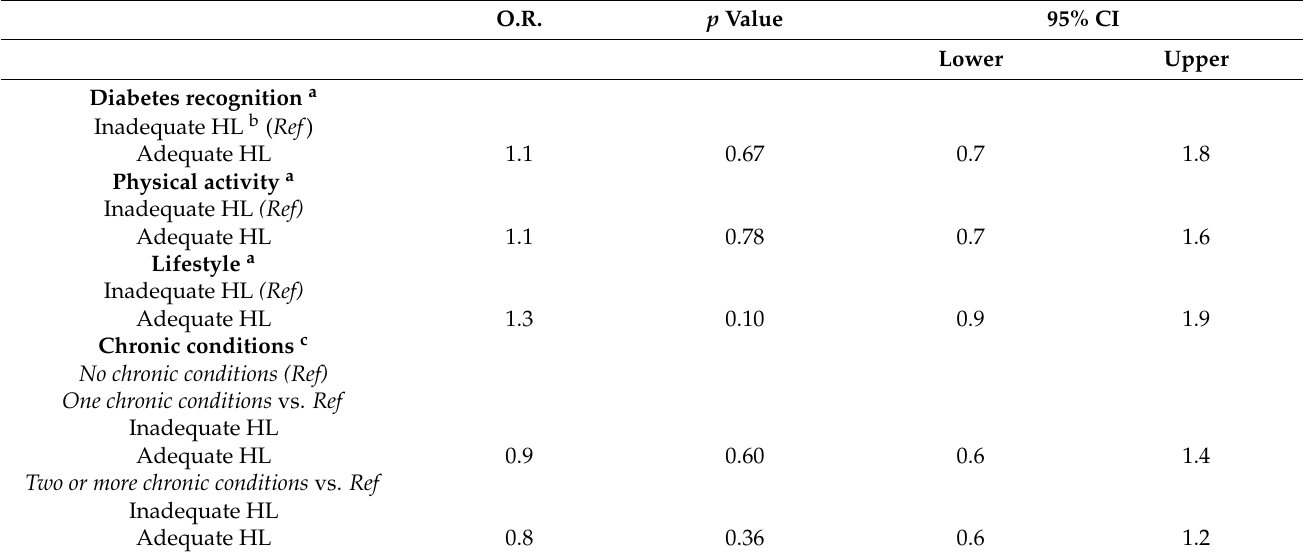
Table 4. Association of HL with chronic conditions, diabetes recognition, PA and lifestyle.